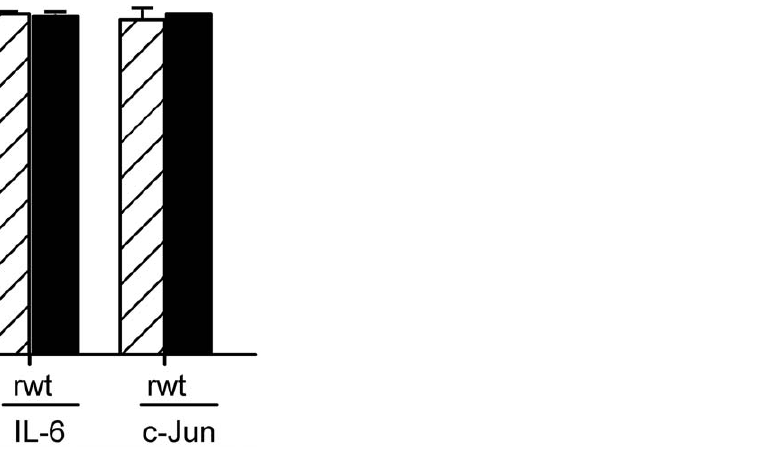
Figure 7. Effects of silencing the expression of Rae1 on accumulation of host mRNAs in nuclei of VSV-infected cells. Cells were transfected with Rae1 siRNA or NT siRNA and were either mock infected or infected with rwt virus for 6 hours. Cells were lysed and separated into nuclear and cytoplasmic fractions. E.coli mRNA was added to each fraction to quantify recovery of RNA. Actin, IL-6, or c-Jun transcripts were measured in each fraction using real time RT PCR and normalized to the amount of E.coli uidA transcripts. The graph represents the amount of nuclear mRNA expressed as a percentage of total mRNA. The data shown are means 6 standard deviation from three independent experiments for actin and two independent experiments for IL-6 and